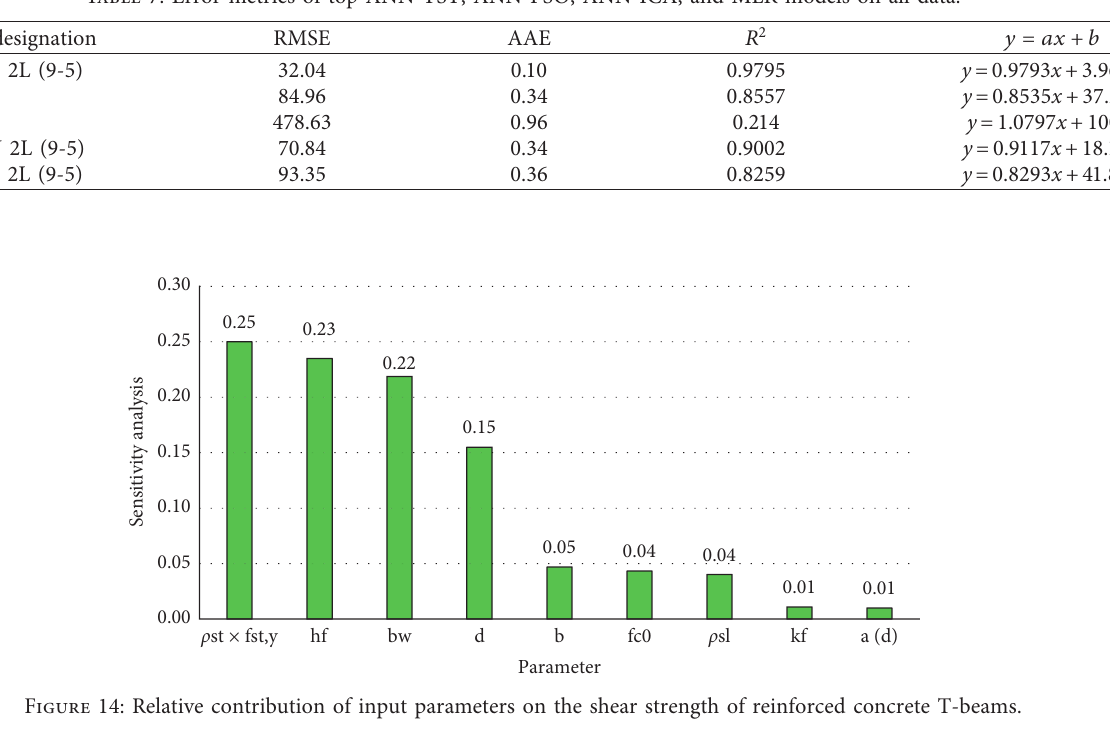
Table 7: Error metrics of top ANN-TST, ANN-PSO, ANN-ICA, and MLR models on all data.